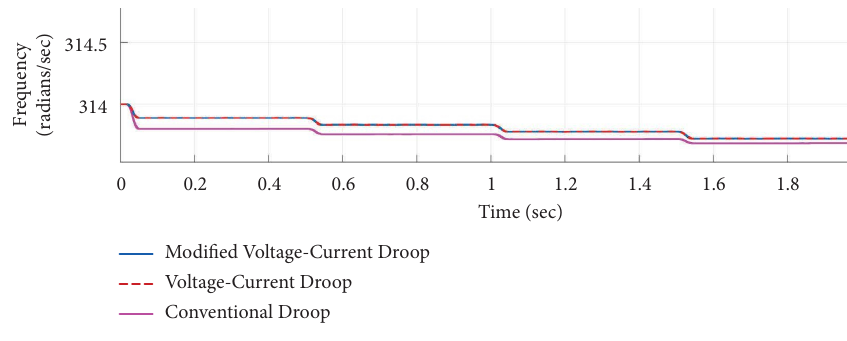
Figure 11: Frequency of 5 bus test Figure 18. Te total power consumption with the capa- bility to achieve DSM is signifcantly reduced in the range of 15%–18% in the case of a 9 bus test system as observed in Figure 19. Table 4 shows the power saving phenomena for 9 bus test system.